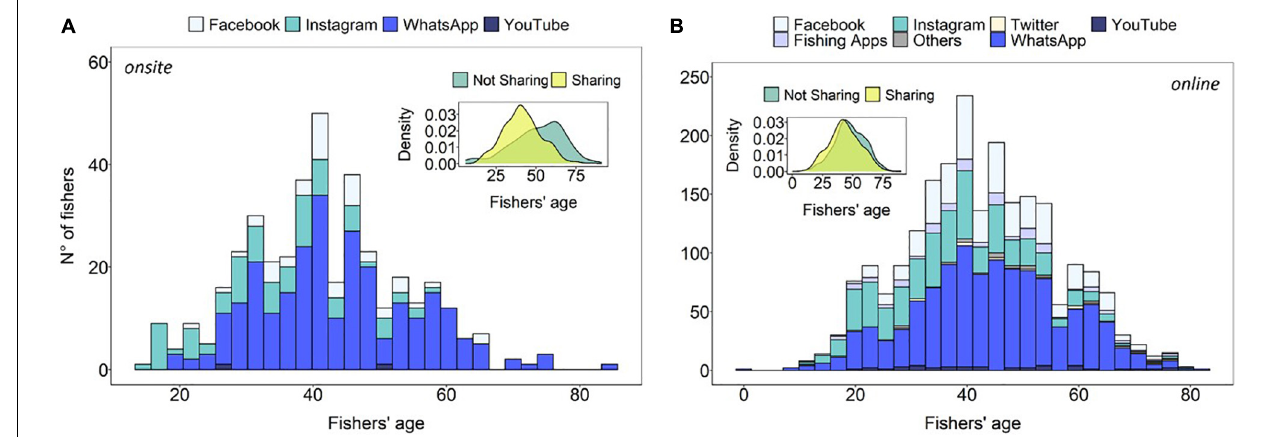
FIGURE 4 | Age distribution of sharers and non-sharers (inlets) for different digital platforms ( A for onsite and B for online surveys). In the onsite survey (A) , the median age of non-sharers was 53 years; for sharers median age was 41 years (Instagram: N = 86, 35 years; YouTube: N = 2, 39 years; Facebook: N = 43, 42 years; and WhatsApp: N = 267, 42 years). In the online questionnaire (B) , the median age of non-sharers was 47; for sharers, the median age was 43 (Instagram: N = 509, 36 years; YouTube: N = 40, 42 years; Fishing Apps: N = 97, 43 years; Facebook: N = 421, 43 years; Twitter: N = 21, 47 years; and other platforms: N = 29, 45 years).